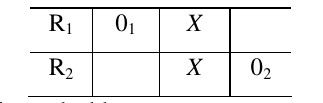
Figuur 2 : Die verdeelde groep voortoets-natoets